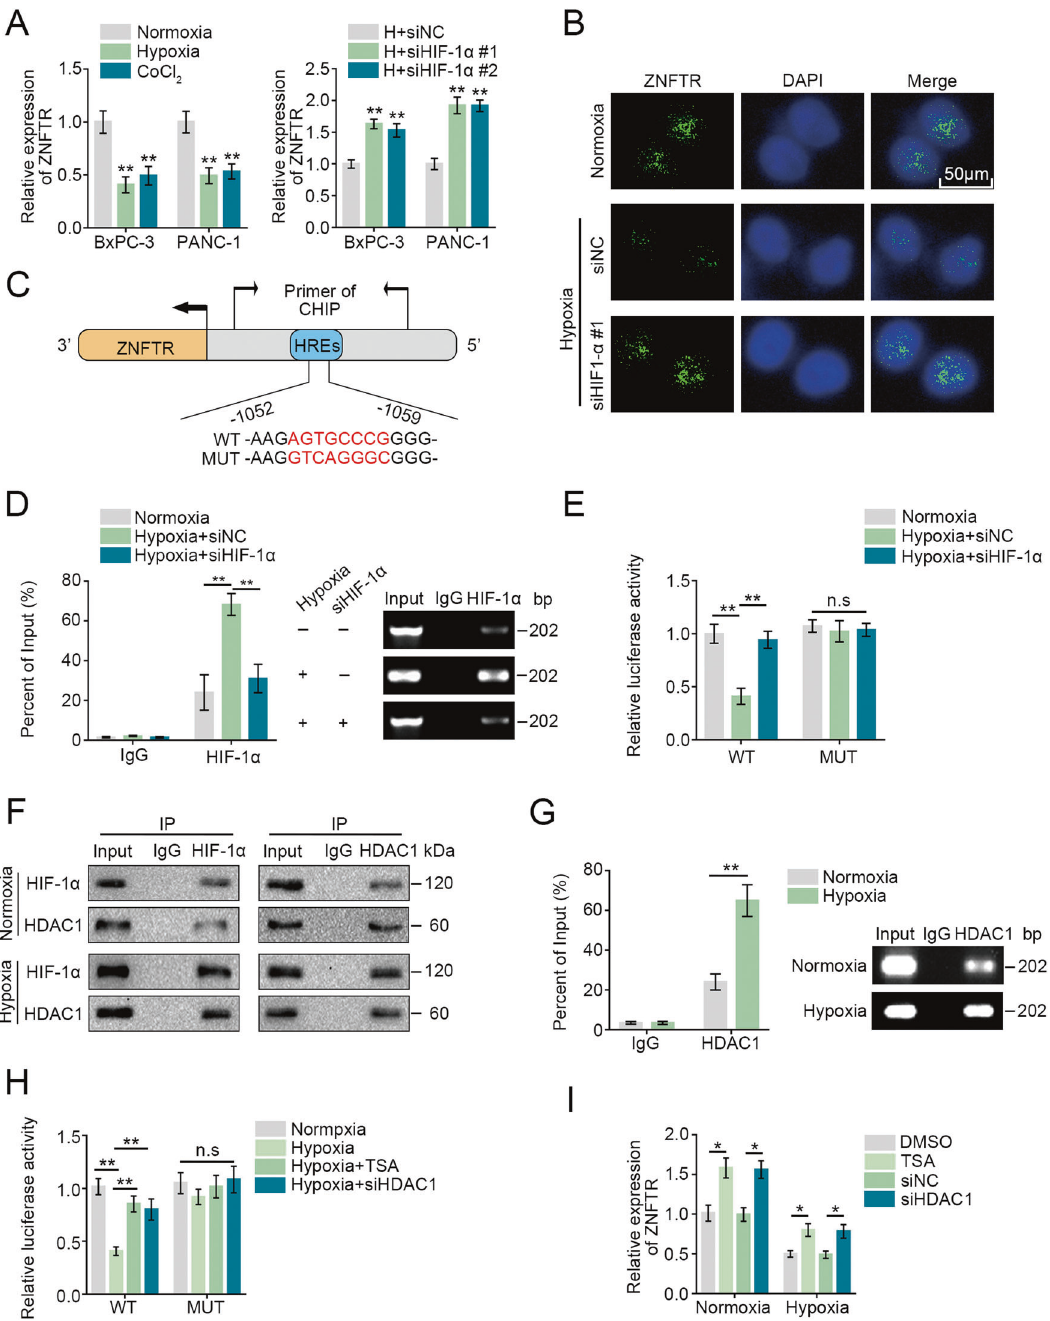
Fig. 6 ZNFTR was downregulated by the complex of HIF1- α and HDAC1 under hypoxia conditions. A The relative expression of ZNFTR under normoxia, hypoxia (1% O 2 ), and CoCl 2 (100 μ M) for 24 h were analyzed by qRT-PCR. The expression of ZNFTR was analyzed after transfected siNC or siHIF-1 α #1/2 during hypoxia by qRT-PCR. B The expression of ZNFTR in PANC-1 cells under normoxia, hypoxia, or hypoxia and transfected with siHIF-1 α #1 conditions were detected via RNA-FISH assay. DAPI was used to stain the nucleus. Scale bar: 50 µm. C The schematic diagram showed the predicted binding site between HIF-1 α and the promoter of ZNFTR. D ChIP assay was utilized to analyze the binding between HIF-1 α and the promoter of ZNFTR under normoxia, hypoxia, or hypoxia and transfected with siHIF-1 α #1. E After transfected with a vector containing wild type (WT) or mutant binding site (MUT) of ZNFTR promoter, transcription activity of the ZNFTR was assessed via luciferase reporter assay under normoxia, hypoxia, or hypoxia and transfected with siHIF-1 α #1 in PANC-1 cells. F The Co-IP assay was conducted to demonstrate the interaction between HIF-1 α and HDAC1 during normoxia and hypoxia. G ChIP assay was utilized to analyze the binding interaction between HDAC1 and promoter of ZNFTR under normoxia and hypoxia conditions. H After PANC-1 cells transfected with a vector containing wild type (WT) or mutant binding site (MUT) of ZNFTR promoter, transcription activity of ZNFTR was assessed via luciferase reporter assay under normoxia, hypoxia, hypoxia with TSA (10 μ M) for 3 h, or hypoxia with siHDAC1 condition. I The relative expression of ZNFTR on DMSO (150 μ M) for 3 h or TSA (10 μ M) for 3 h, and transfected with siNC or siHDAC1 during normoxia and hypoxia were detected by qRT-PCR. All data were revealed as means ± standard deviation (SD) for no less than three independent experiments. Signi fi cant P values showed as * P < 0.05 and ** P < 0.01. n.s. means the difference was not signi fi